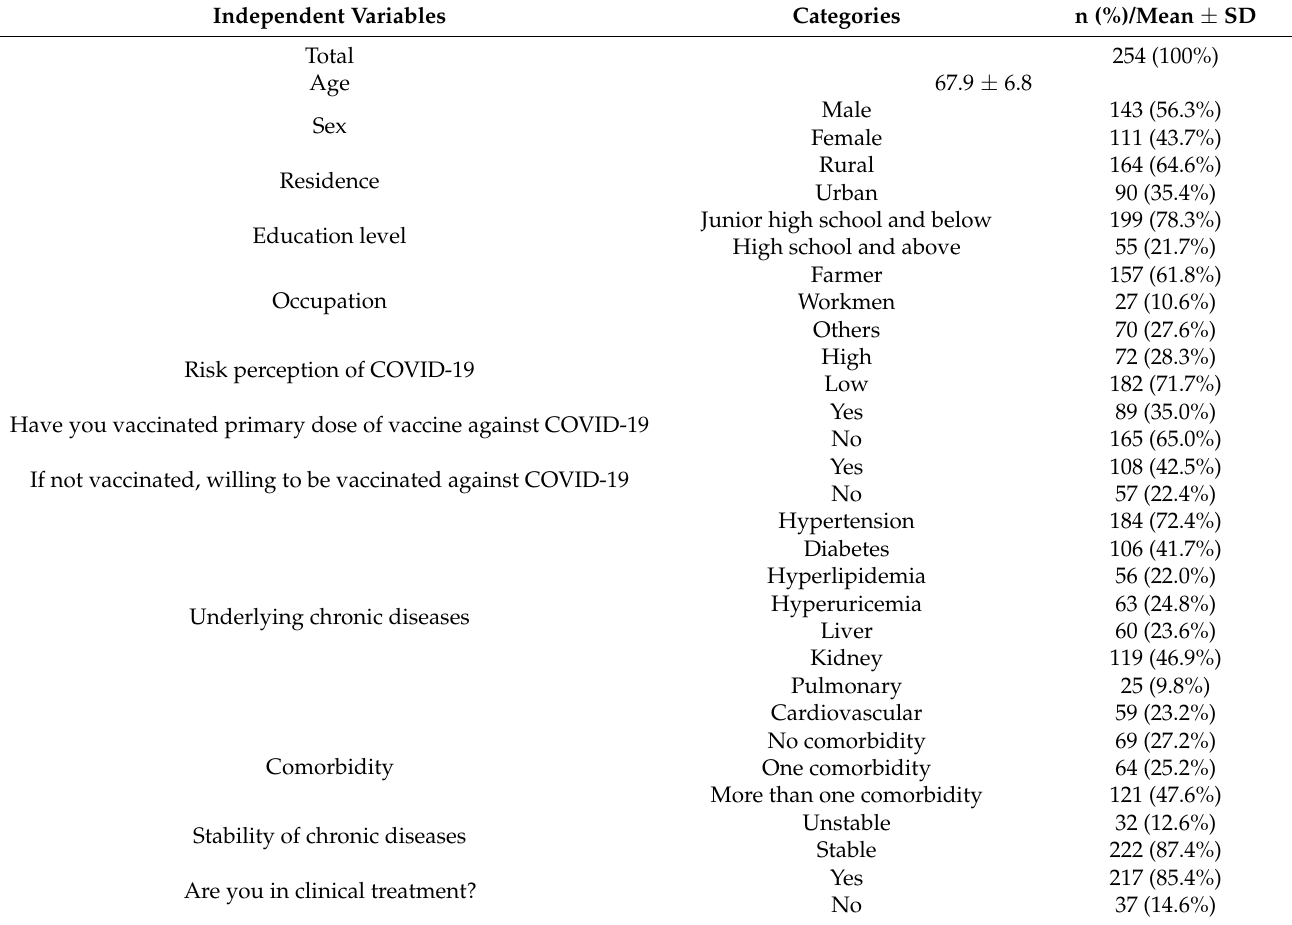
Table 1. Demographic characteristics of the study population, n =